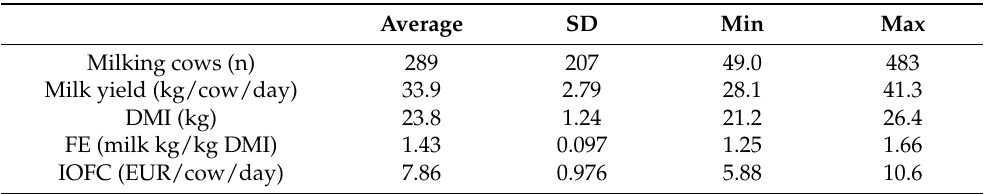
Table 1. Average, standard deviation (SD), minimum (Min) and maximum (Max) values of the main characteristics and performance of the recruited farms.